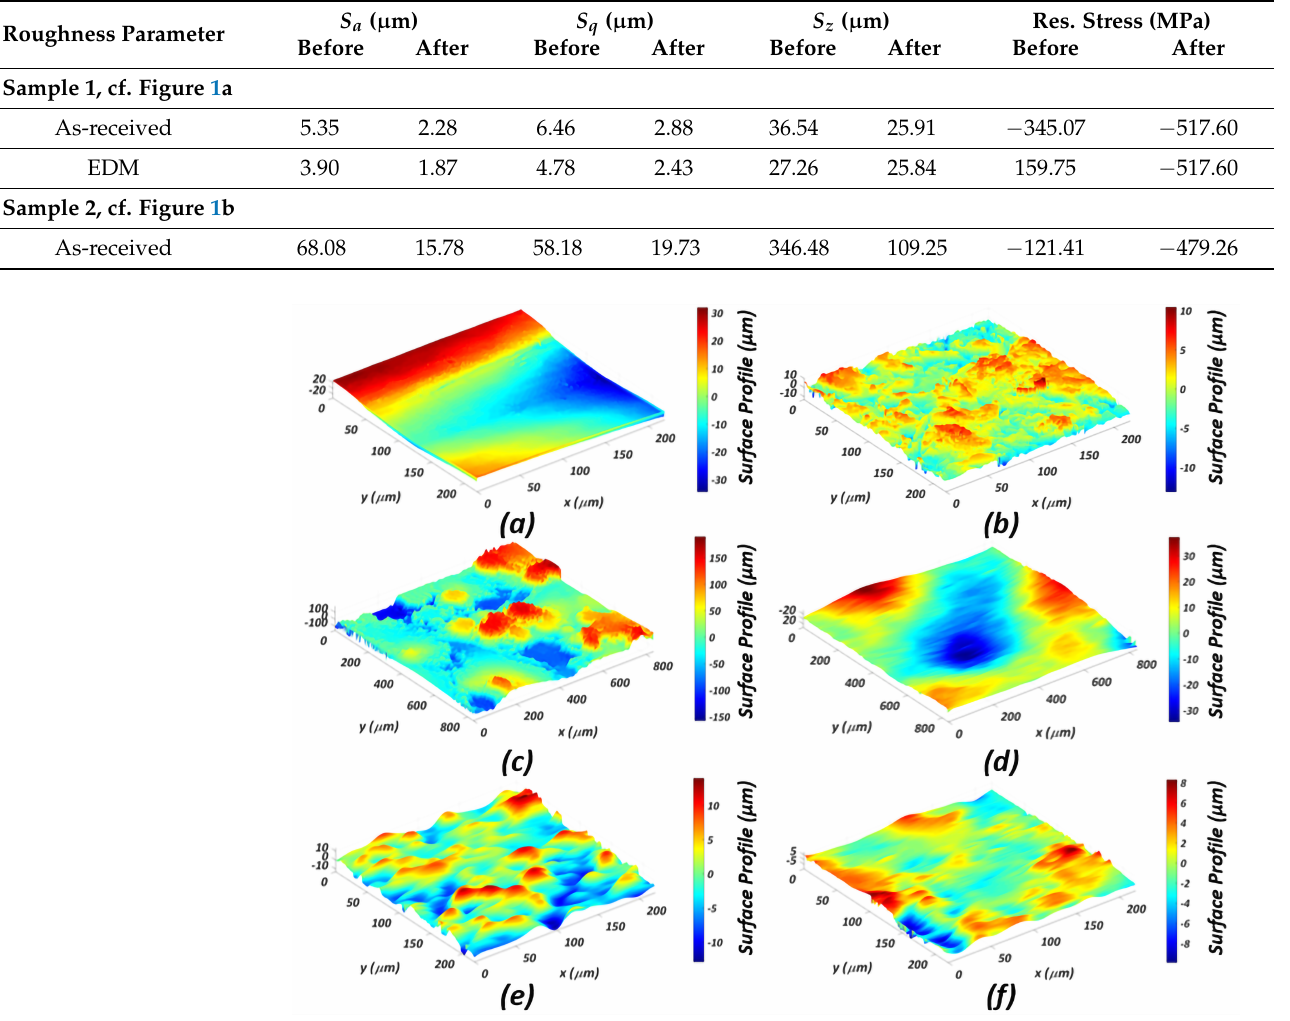
Table 1. Roughness characteristics S a , S q , and S z and their surface residual stresses.